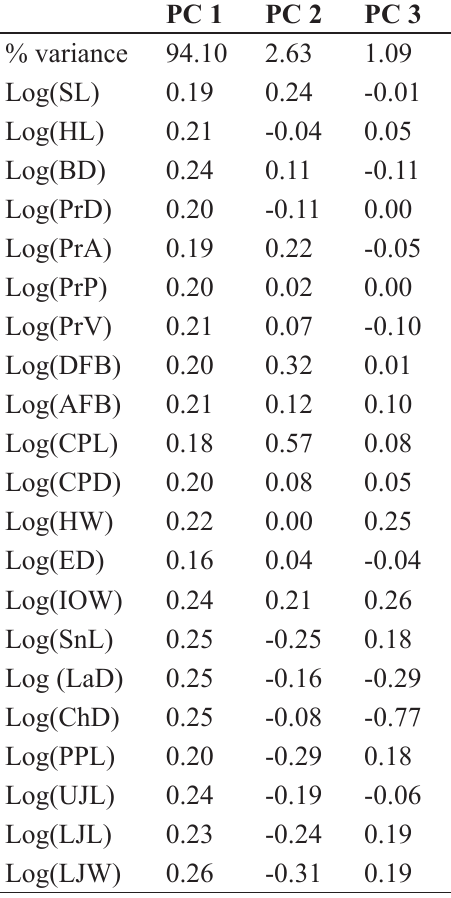
Table S5. PCA loadings of 21 log-transformed measurements from: H . aquila sp. nov., H . falcatus sp. nov., and H . curvidens sp. nov.. Results illustrated in Fig. 3e. Abbreviations: SL = standard length; HL = head length; BD = body depth; PrD = predorsal distance; PrA = preanal distance; PrP = prepectoral distance; PrV = prepelvic distance; DFB = dorsal fin base length; AFB = anal fin base length; CPL = caudal peduncle length; CPD = caudal peduncle depth; HW = head width; ED = eye diameter; IOW = interorbital width; SnL = snout length; LaD = lachrymal depth; ChD = cheek depth; PPL =